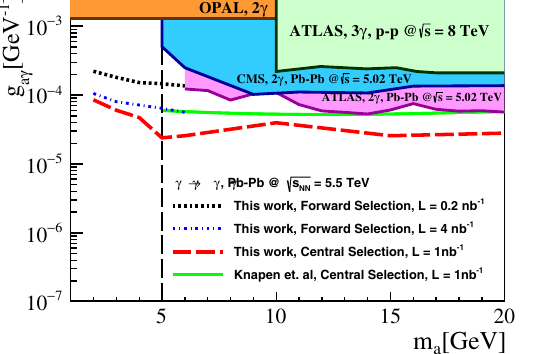
ing exclusion limits derived in e + e − , pp and PbPb collisions are rep- resented by the various shaded regions